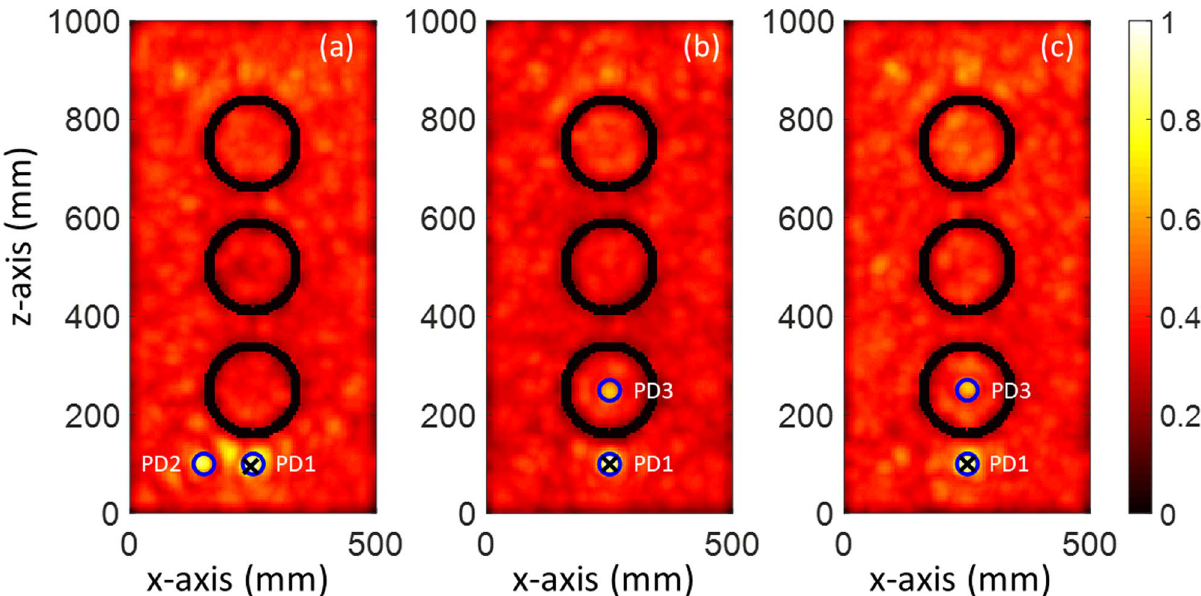
Figure 6. The Distribution of the normalized maximum y-component of the electric field intensity in the x–z cut plane (CS #1). The blue circles and black cross show, respectively, the actual locations of the PD sources and of the maxima of the electric field intensity. ( a ) Scenario based on CS#2, ( b ) scenario based on CS#3 with simultaneous PD sources, and ( c ) scenario based on CS#3 with non-simultaneous PD